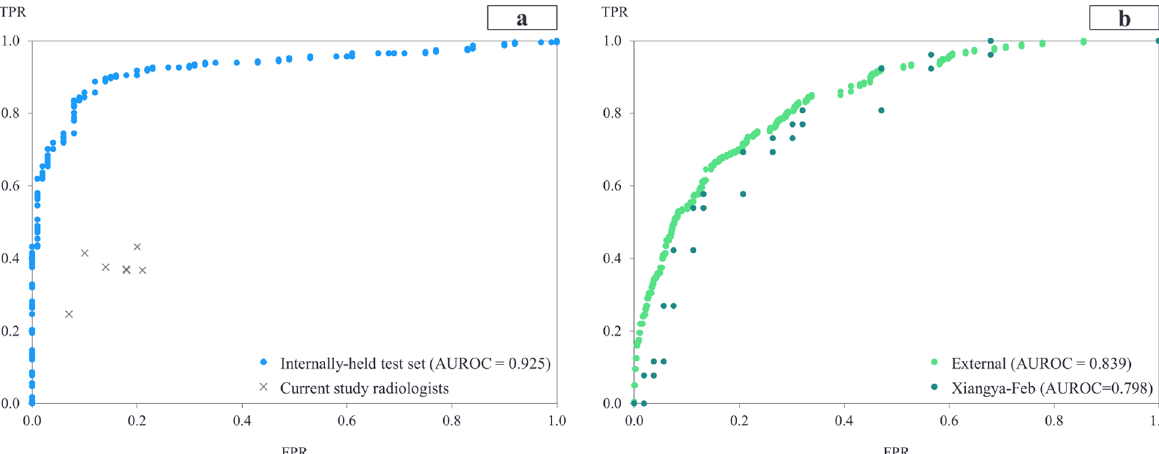
Fig. 1 COVID-19 diagnosis AUROC curves for the internally held-out and external test sets. The true and false positive rates for the study ’ s radiologists are also portrayed to assess model performance relative to traditional clinical methods. a Internally held-out test set and b external test set. TPR true positive rate, FPR false positive rate.